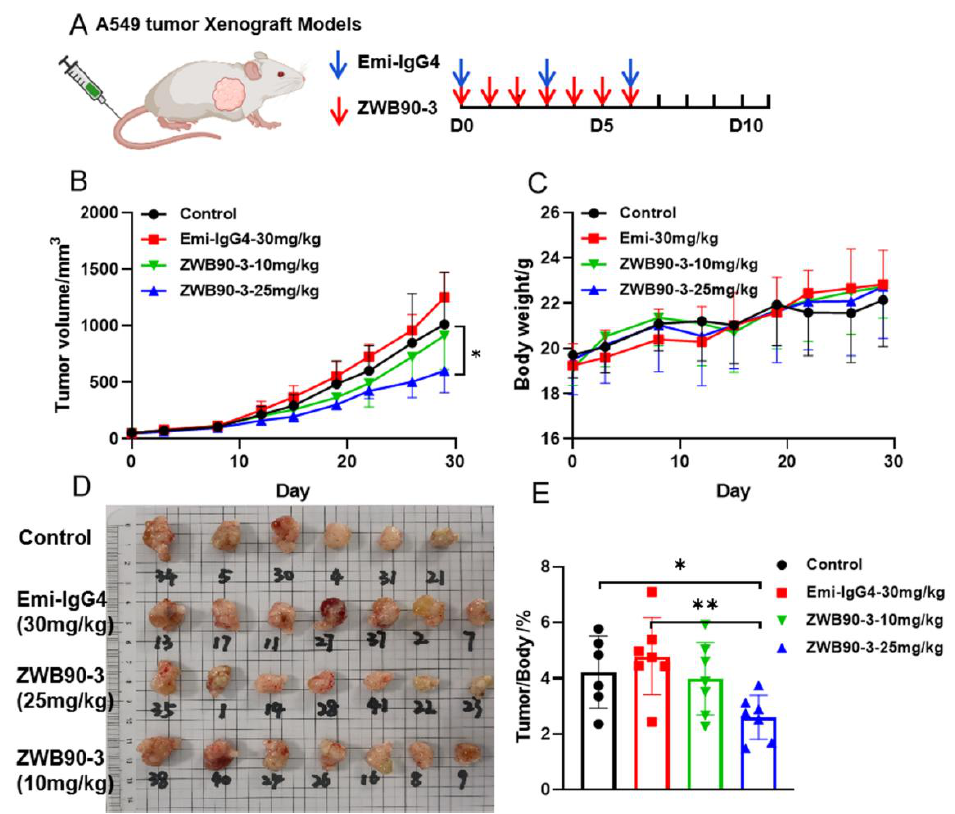
Figure 6. Anti-tumor effects of ZWB90-3 in the A549 NSCLC xenograft mouse model. ( A ) Drug administration scheme. ( B ) Mice were intravenously injected with 10 mg/kg and 25 mg/kg doses of ZWB90-3, and the two control groups were treated with PBS or 30 mg/kg of Emi-IgG4. A total of seven mice per group was used for the study. * p < 0.05 was considered significant as compared to the vehicle control. ( C ) Mice body weight curve. ( D ) Tumor tissues were dissected and photographed. ( E ) Tumors were weighed and the tumor-to-body weight ratio was calculated. * p < 0.05 was considered significant as compared to the vehicle control. ** p < 0.01 was considered significant as compared to Emi-IgG4 group.